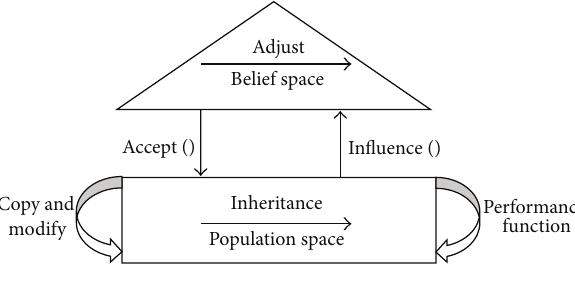
Figure 2: Basic framework of cultural algorithm.